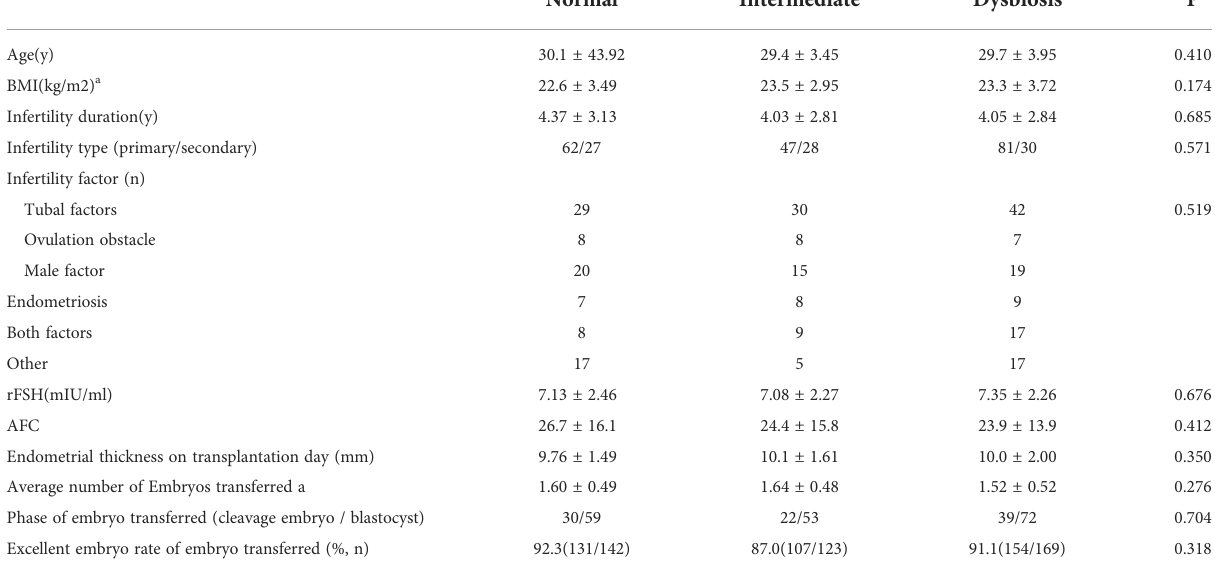
TABLE 1 Baseline characteristics of patients with different vaginal fl